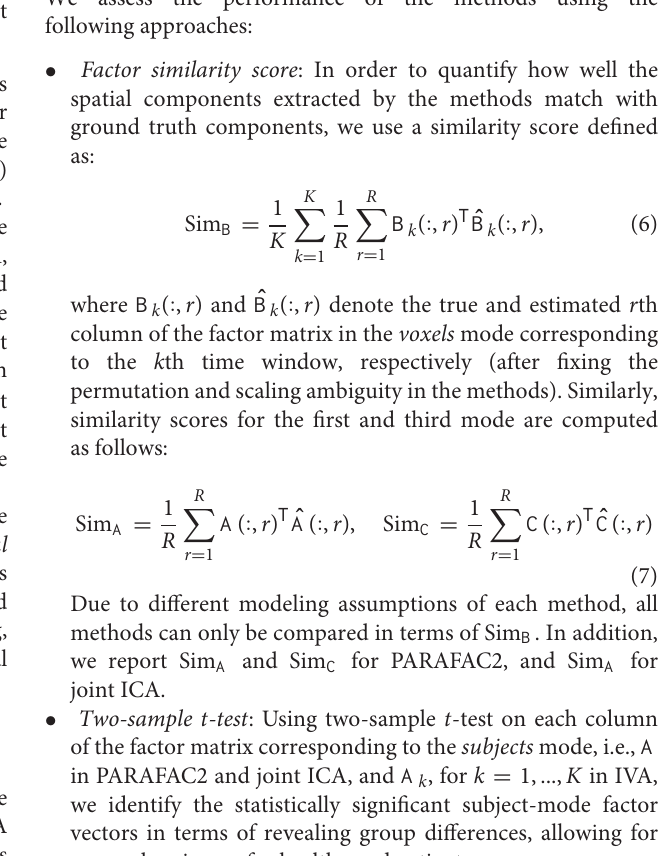
algorithm based on entropy bound minimization (ICA-EBM)